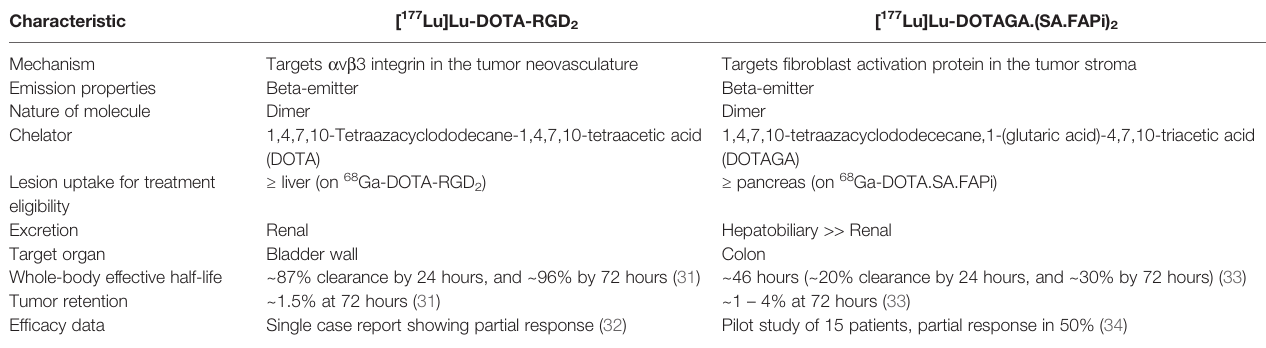
TABLE 1 | Salient features of [ 177 Lu]Lu-DOTA-RGD 2 and [ 177 Lu]Lu-DOTAGA.(SA.FAPi) 2 theranostic strategies.